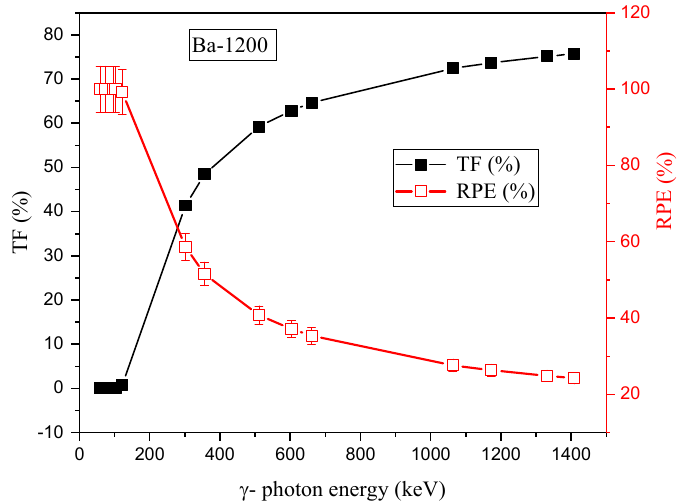
Figure 9. Influence of the emitted γ -photon energy (E γ ,keV) on the transmission factor (TF,%) and radiation-protection efficiency (RPE,%) of the prepared samples.